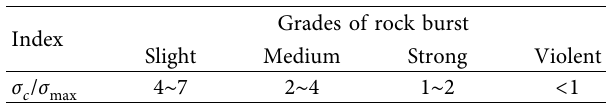
Table 3: Rock burst grades using the ratio of σ criterion ∗